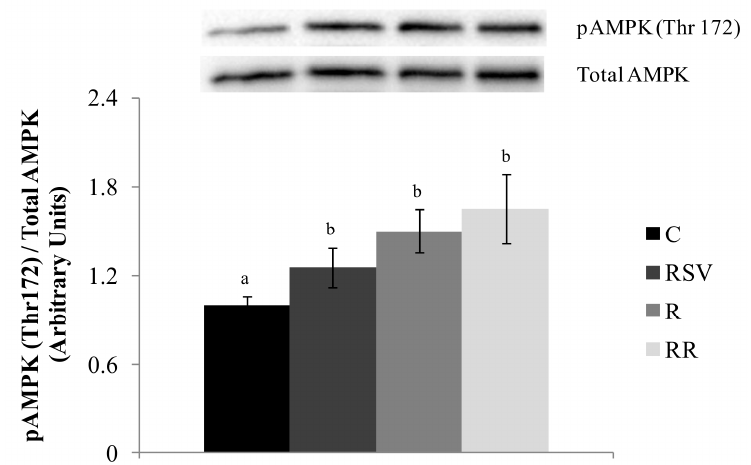
Figure 4. Phosphorylated AMPK (threonine 172)/Total AMPK ratio in liver from rats fed an obesogenic diet for six weeks, and then fed a standard diet (C), or a standard diet supplemented with resveratrol (RSV), or submitted to energy restriction and fed a standard diet (R) or submitted to energy restriction and fed a standard diet supplemented with resveratrol (RR) ( n = 9/group) for additional six weeks. Values are mean ± SEM. Differences among groups were determined by using one-way ANOVA followed by Newman Keuls post-hoc test. Values not sharing a common letter are significantly different ( p < 0.05). AMPK: AMP activated protein kinase.